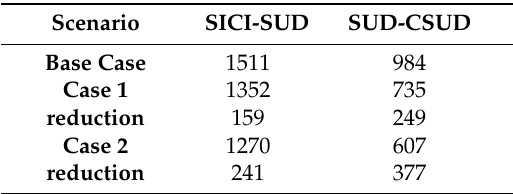
Table 10. Hours in which SICI-SUD and SUD-CSUD lines are congested during one year in the three cases